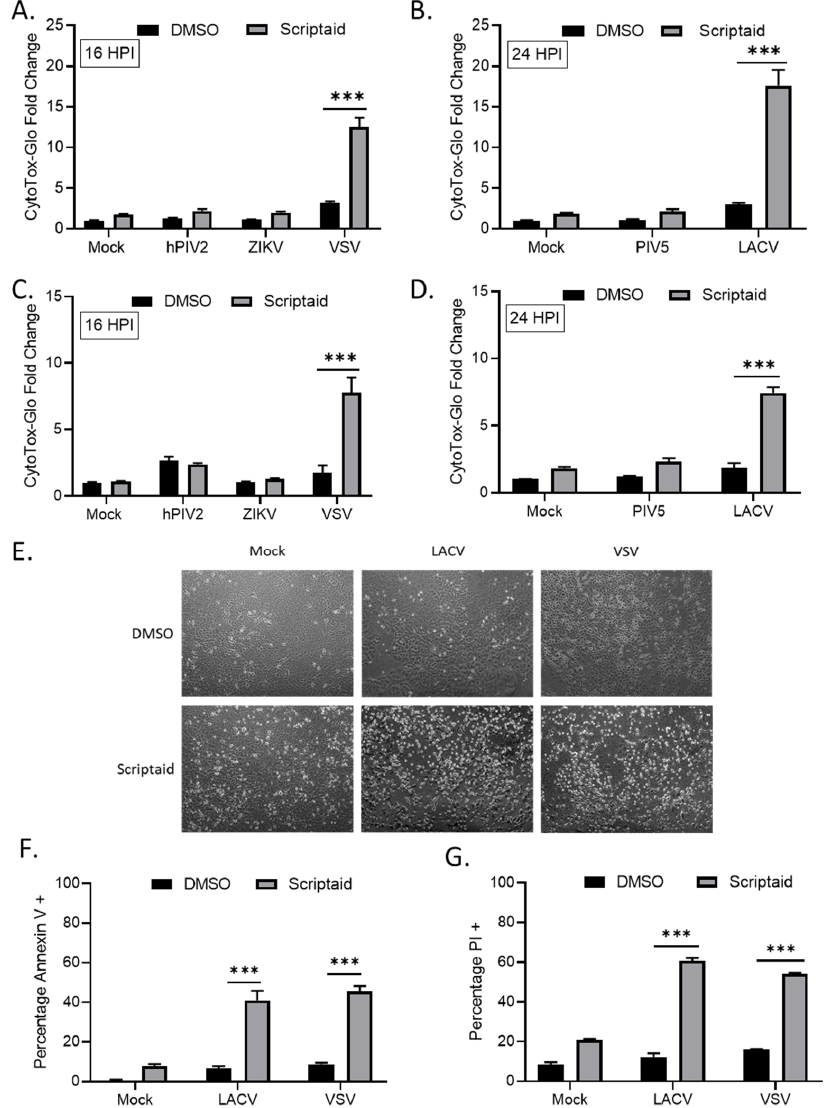
Figure 4. HDAC inhibitor pretreatment enhances cell death by other RNA viruses. ( A – D ) H1299 ( A , B ) or A549 ( C , D ) cells were pretreated with 20 µ M scriptaid or DMSO for 12 h. Cells were then either mock infected or infected with the indicated viruses at an MOI of 10. After culturing in the presence of 1 µ M scriptaid or DMSO for either 16 ( A , C ) or 24 ( B , D ) h, cytotoxicity was determined by CytoTox-Glo assay. hPIV2, human parainfluenza virus 2; ZIKV, Zika virus; VSV, vesicular stomatitis virus. LACV, La Crosse virus. Values are the mean of three replicates normalized to DMSO pretreated mock infected samples, with error bars indicating standard deviation. ** and *** indicating p -values of < 0.01 and < 0.001, respectively. ( E – G ) A549 cells were pretreated with 20 µ M scriptaid or DMSO and either mock infected or infected with LACV or VSV at MOIs of 10. After culturing in the presence of 1 µ M scriptaid or DMSO for 16 h, cells were imaged at 10 × magnification, and representative bright field images are shown ( E ). Cell viability was determined by annexin V ( F ) and PI ( G )